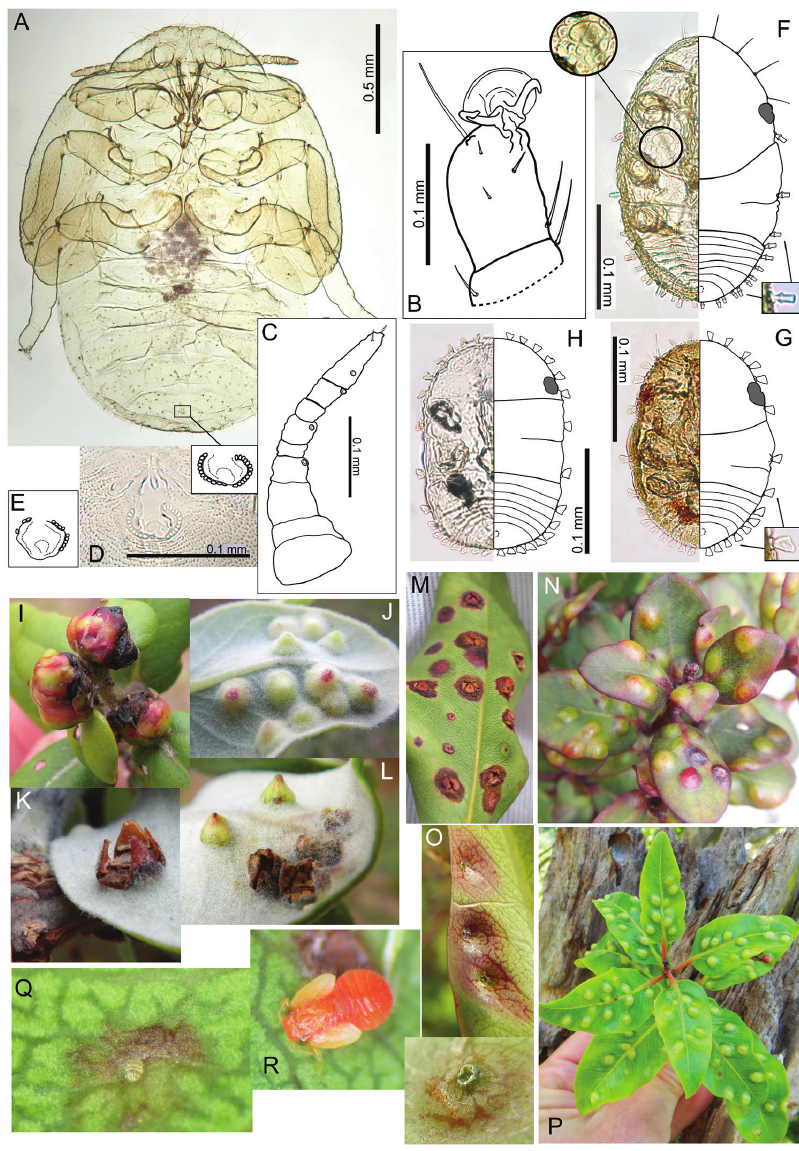
Figure 50. Pariaconus oahuensis and Pariaconus ohiacola immatures. A–D P. oahuensis : A 5 th instar with anal ring detail (inset) B tarsi C antenna D anal ring E P. ohiacola anal ring F–H 1 st instar: F P. oahuen- sis with dorsal tubercles detail (inset left) and marginal sectasetae detail (inset right) G P. ohiacola form ohiacola with marginal fan-shaped setae detail (inset) H P. ohiacola form angustipterus I–L P. oahuensis galls: I bud gall J, K, L cone galls on leaves opening with valves on lower leaf surface M–R P. ohiacola : M flat leaf galls open by valves on lower leaf surface N variation in discolouration of gall tissue O circular sutures in gall centres from 1 st instar pits on lower leaf surface with detail (inset) P distribution of flat leaf galls Q 1 st instar seated in pit before leaf tissue enclosure makes enclosed gall R 5 th instar dissected from closed flat leaf